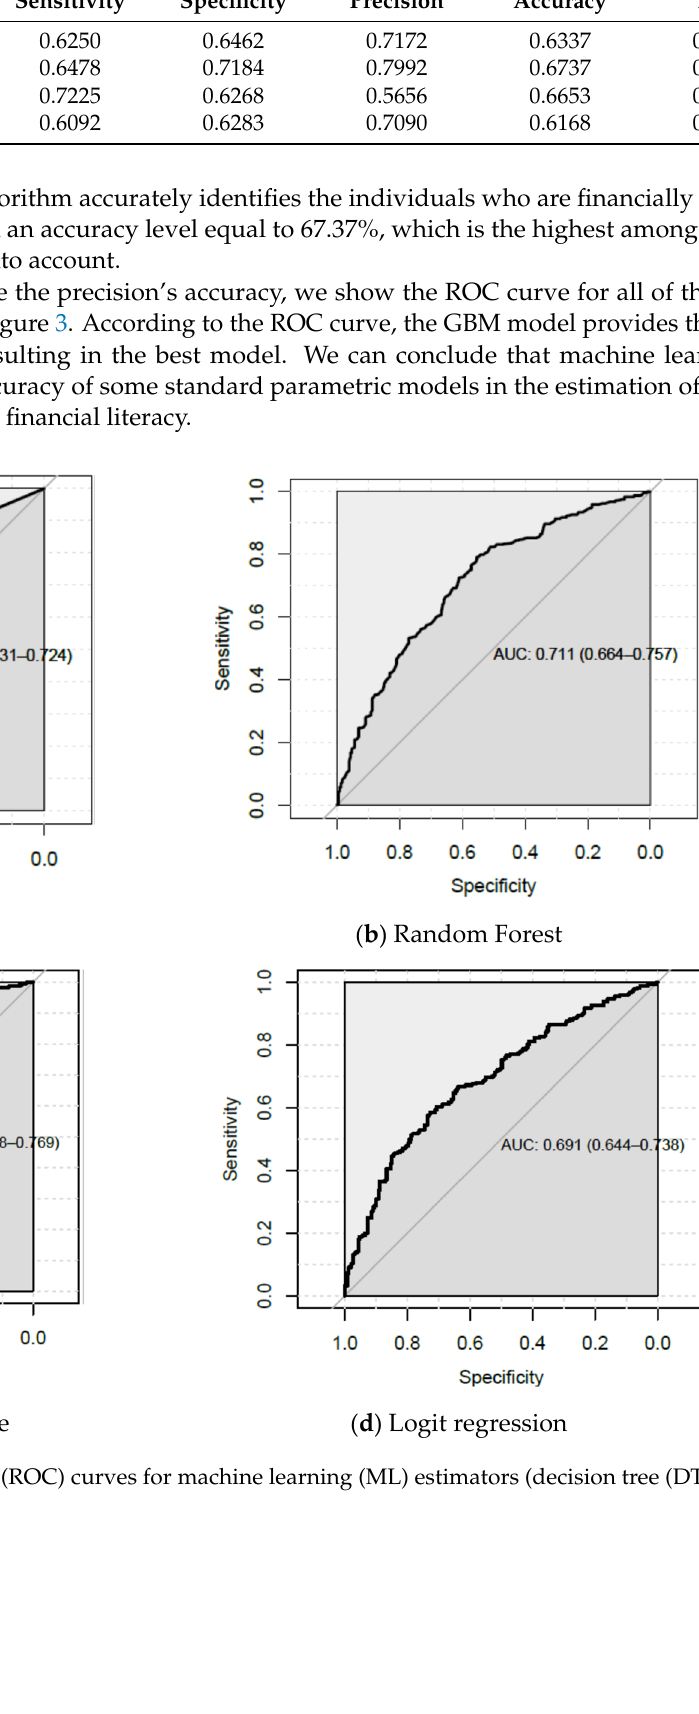
Table 3. Accuracy measures.